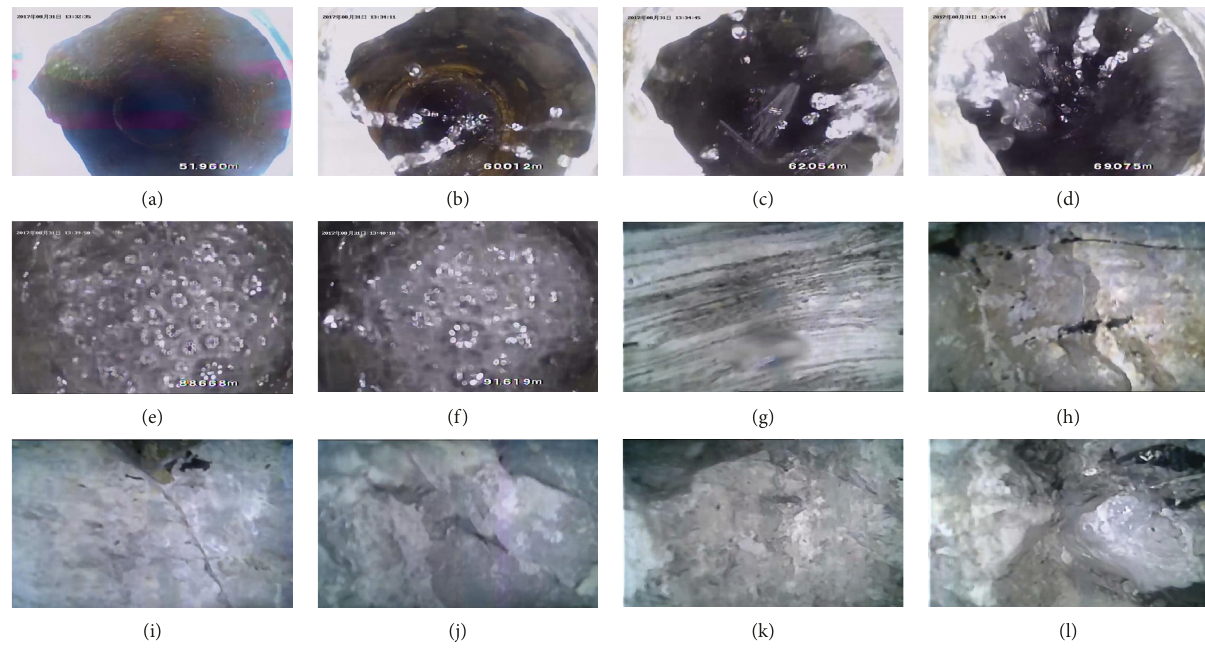
Figure 18: Television observation results of boreholes in exploration area